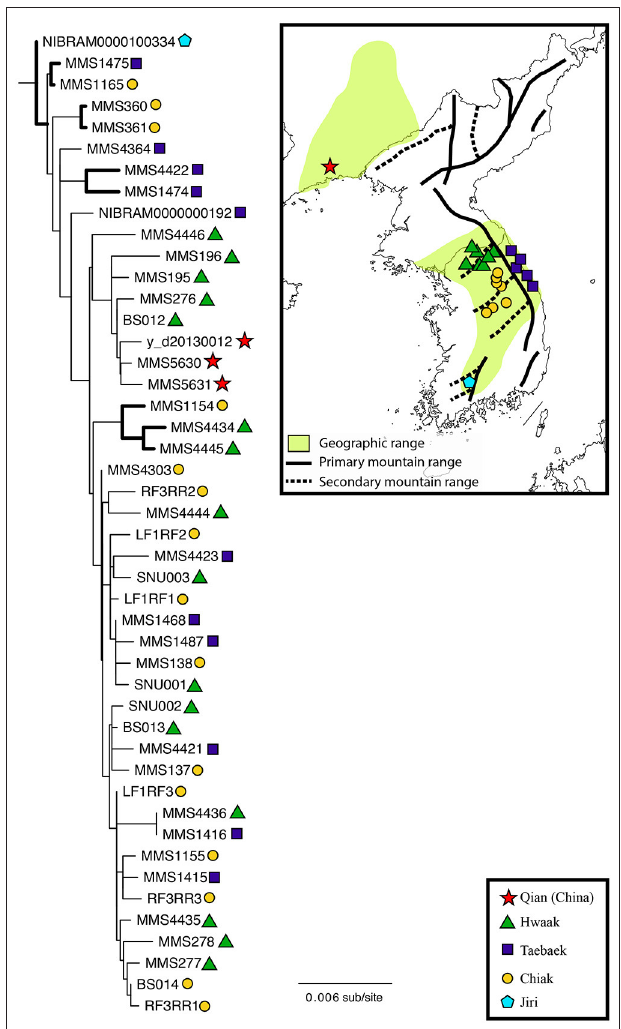
FIGURE 1 | Maximum likelihood phylogeny of Bufo stejnegeri inferred from a concatenated dataset of 10 loci ( 12S-16S , cytb , ND2 , ND3 , ADNP , CXCR-4 , H3A , NTF3 , POMC , RAG-1 ). Thicker branches indicate a bootstrap support value ≥ 85. The shapes next to each individual correspond to the geographic locations on the map to the right. Geographic locations have been grouped into five populations based on the mountain range. The geographic range of B. stegnegeri is indicated by the light-green shading, based on the Map of Life (Jetz et al., 2012). Although this species is expected to occur in North Korea, no data are available. Darker lines on the map (solid and dotted) indicate the location of the major mountain ranges (adapted from Park and Son, 2008).